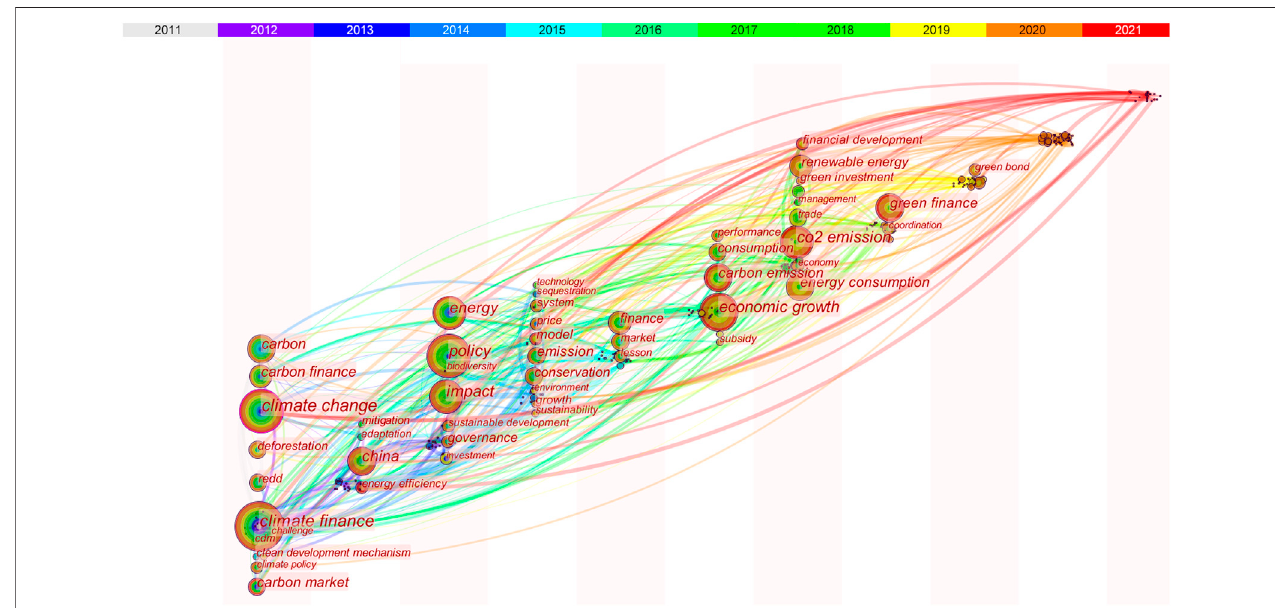
FIGURE 10 | Temporal evolution of keywords from 2011 to 2021. The links refer to the connection of related keywords, the colour of which represents the time of connection. The size of a circle is proportional to the frequency of keywords.